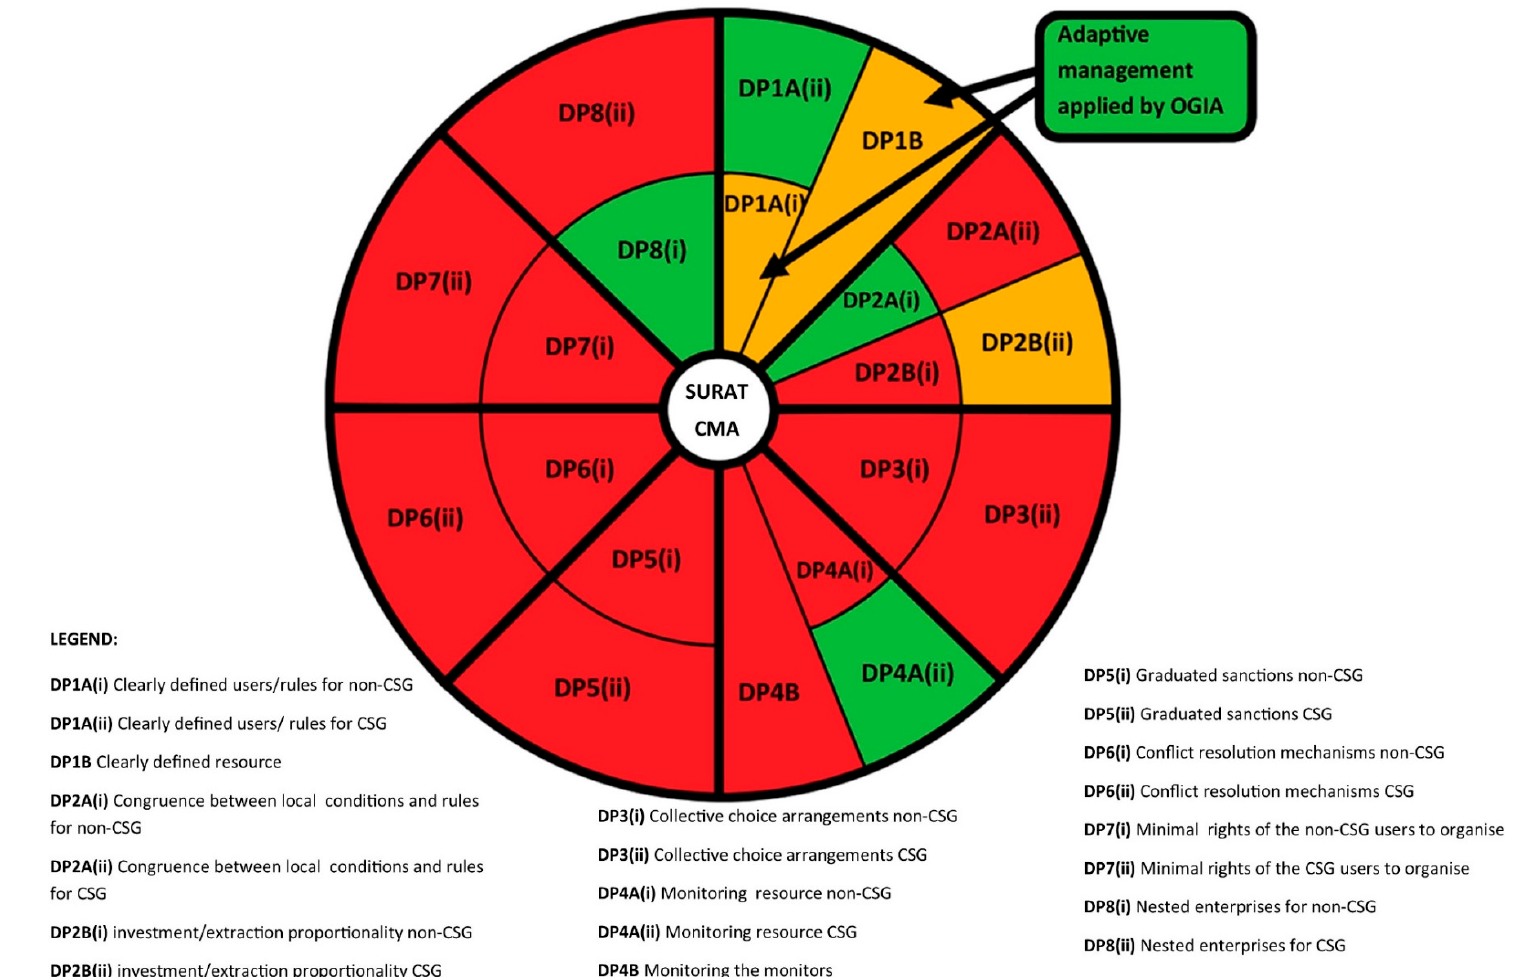
Figure 3. More detailed CPR heatmap illustrating governance framework for extraction of groundwater in the Surat CMA, Qld, Australia .